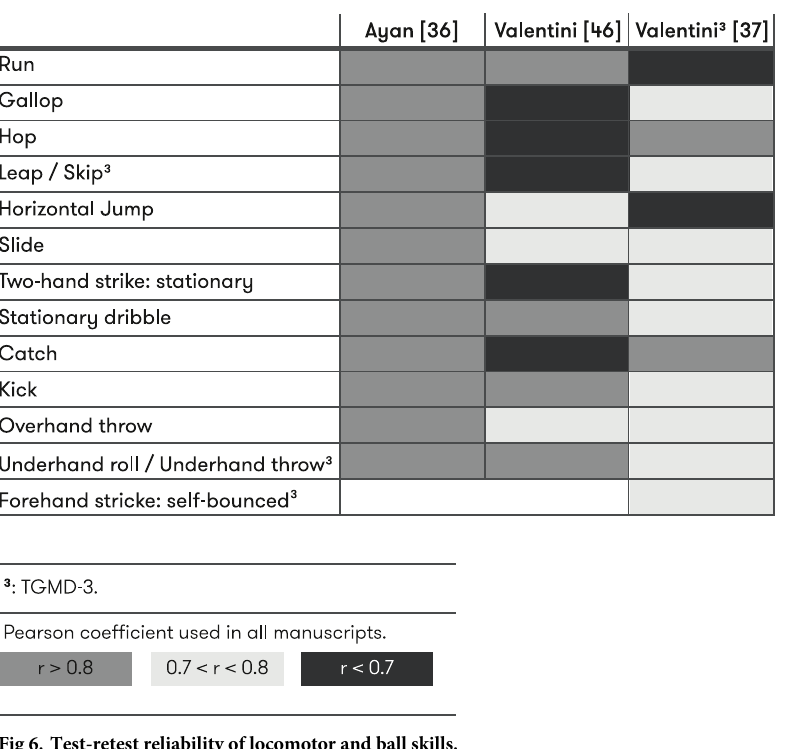
Fig 6. Test-retest reliability of locomotor and ball